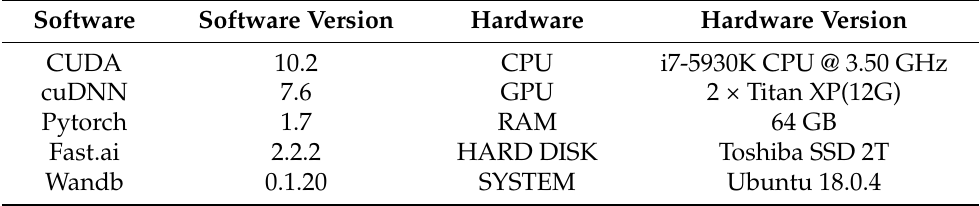
Table A1. Experiment